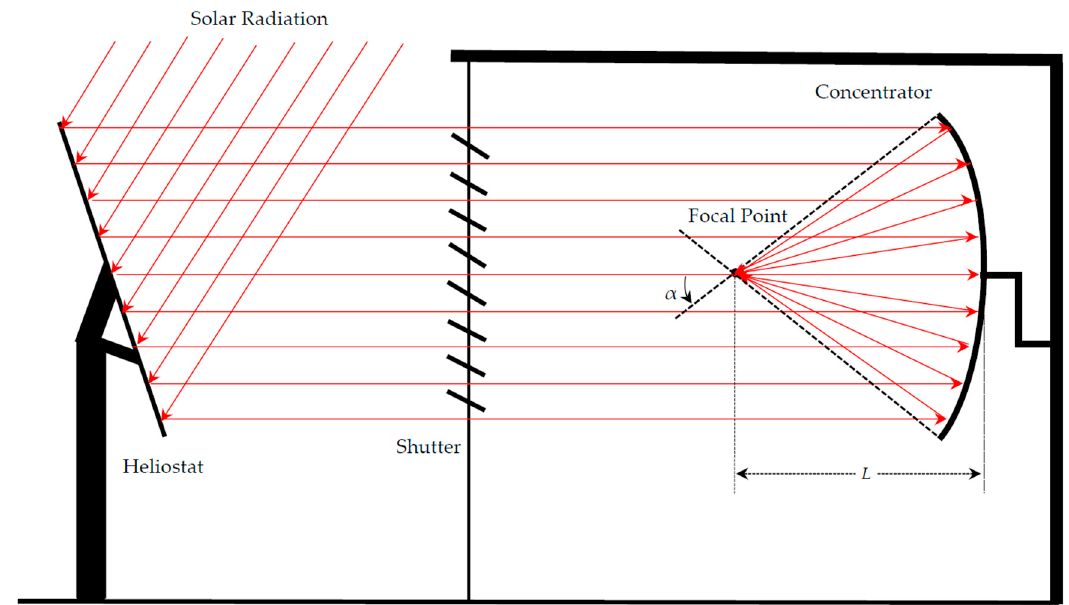
Figure 1. Typical configuration of a high-flux solar furnace, showing its main components: The heliostat, the shutter, and the concentrator ( α is the rim angle; L is the focal length i.e., the distance between the center of the parabolic concentrator and the theoretical focal point).